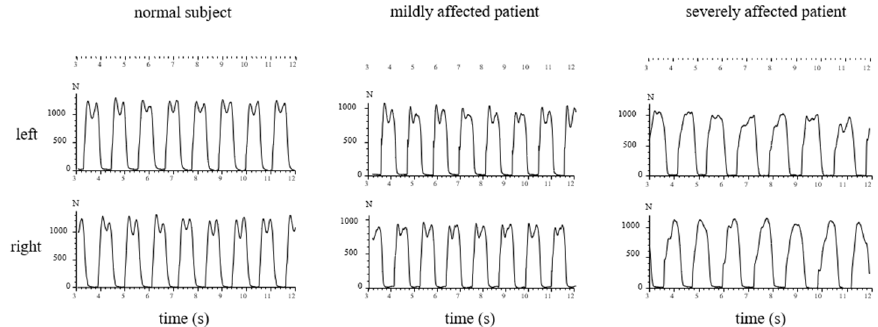
Figure 3. The GRF-curves of a few steps of a normal subject ( left side ), of a moderately affected WD- patient ( middle ), and of a severely affected WD-patient ( right side ) are presented. In the GRF- curves of the normal subject, two peaks can clearly be distinguished (left side). The GRF-curves of the moderately affected patient show a higher first “heel-on”peak, but a lower “push-off”peak ( middle part ). In the severely affected patient, the clear modulation of the GRF-curve with two peaks and the midstance valley is missing ( right side ).